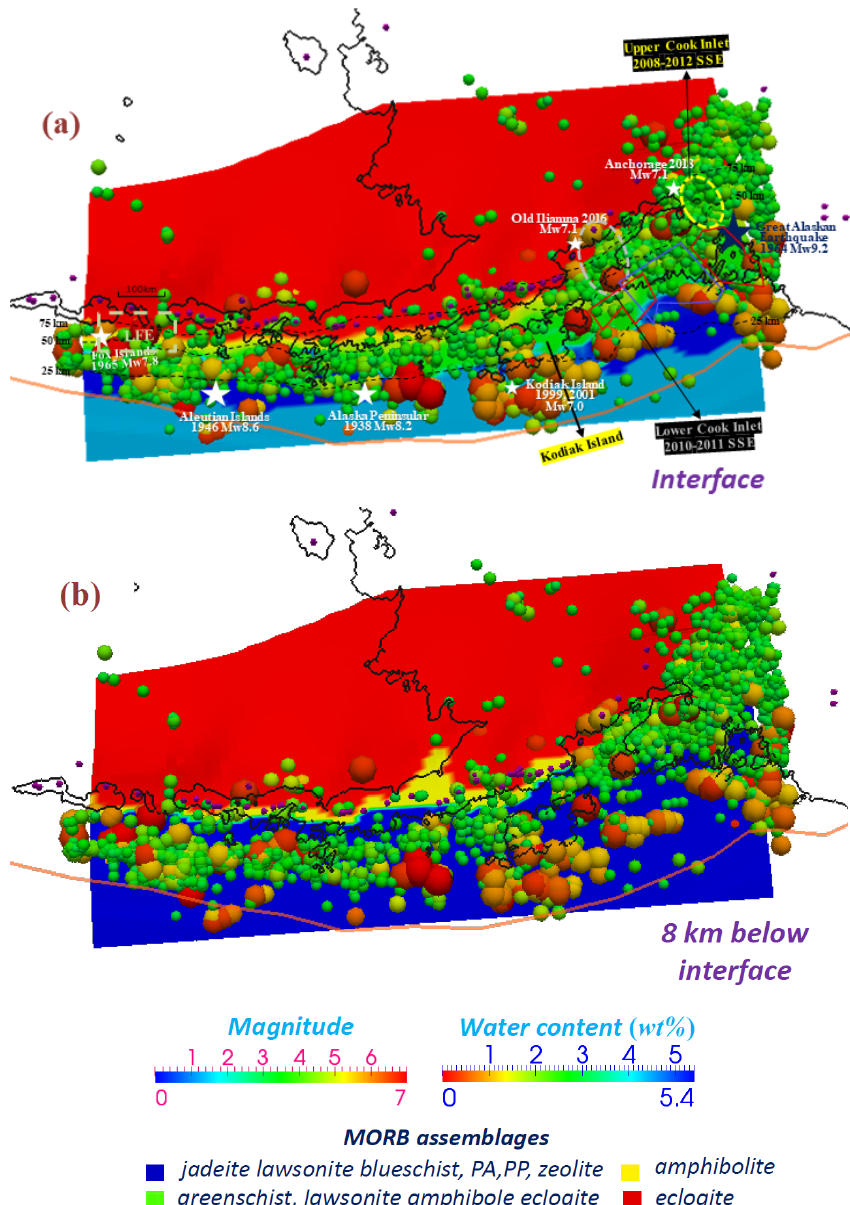
Figure 4. Slab water content (wt%) was calculated at depths of ( a ) 0 (subduction interface) and ( b ) 8 km vertically below the interface. The black dashed lines represent the isodepth contours of 25, 50, and 75 km. The yellow and gray dashed circles represent the slow slip event patches in the Upper Cook (2008–2012, [17]) and Lower Cook Inlets (2010–2011, [18]). The green dashed line indicates low-frequency earthquakes [20]. Bold blue lines indicate the 1992.0–2004.8 (~M 7.8) Slow Slip Event, and bold red lines indicate the 2009.85–2011.81 (~M 7.2) Slow Slip Event [21,22].